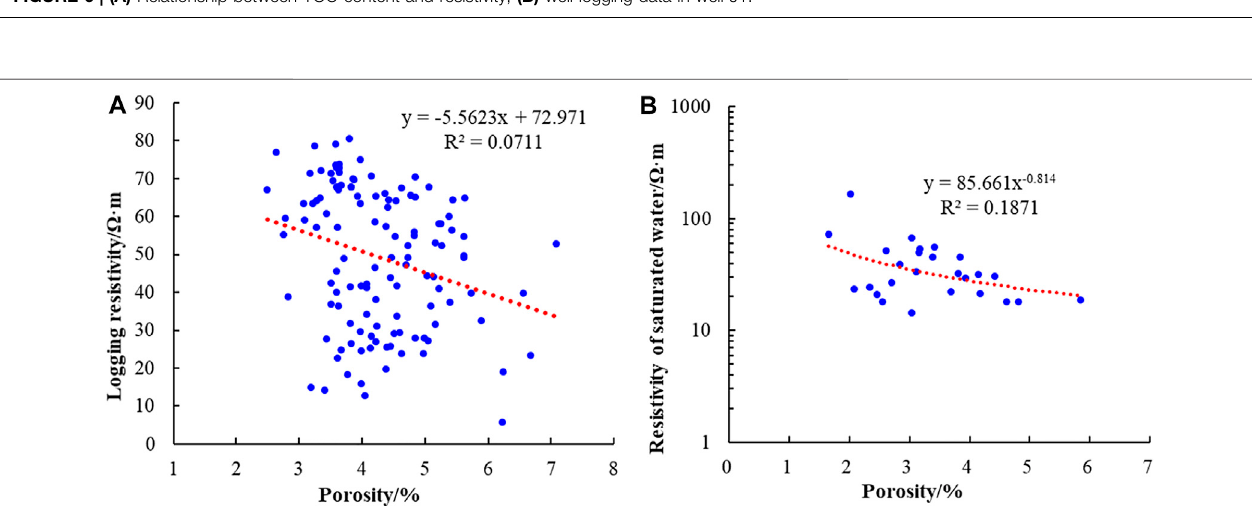
FIGURE 6 | (A) Relationship between TOC content and resistivity; (B) well logging data in well J1.